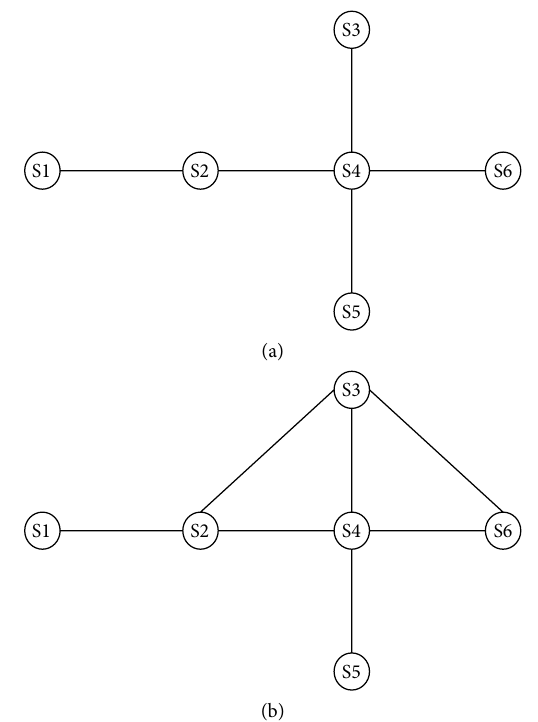
Figure 4: (a) BC and (b) CC